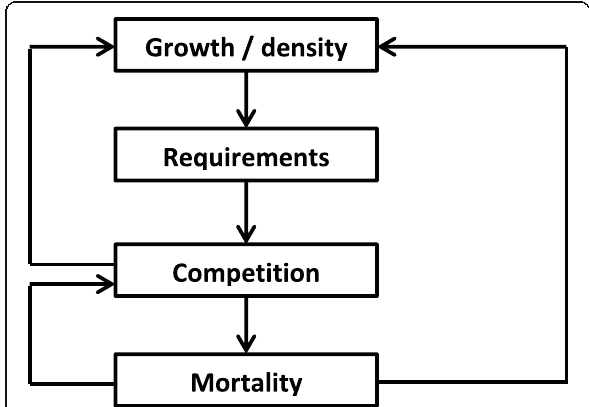
Fig. 4 The relationships between growth, requirements, competition, and death in plant communities. When neighbouring plants grow, their requirements (e.g. light, water, nutrients) increase which leads to the increase of their competitive interaction resulting in a rise in mortality rate. The space freed up by individual mortality contributes to the decrease of competition intensity and stimulation of plant growth and/or density